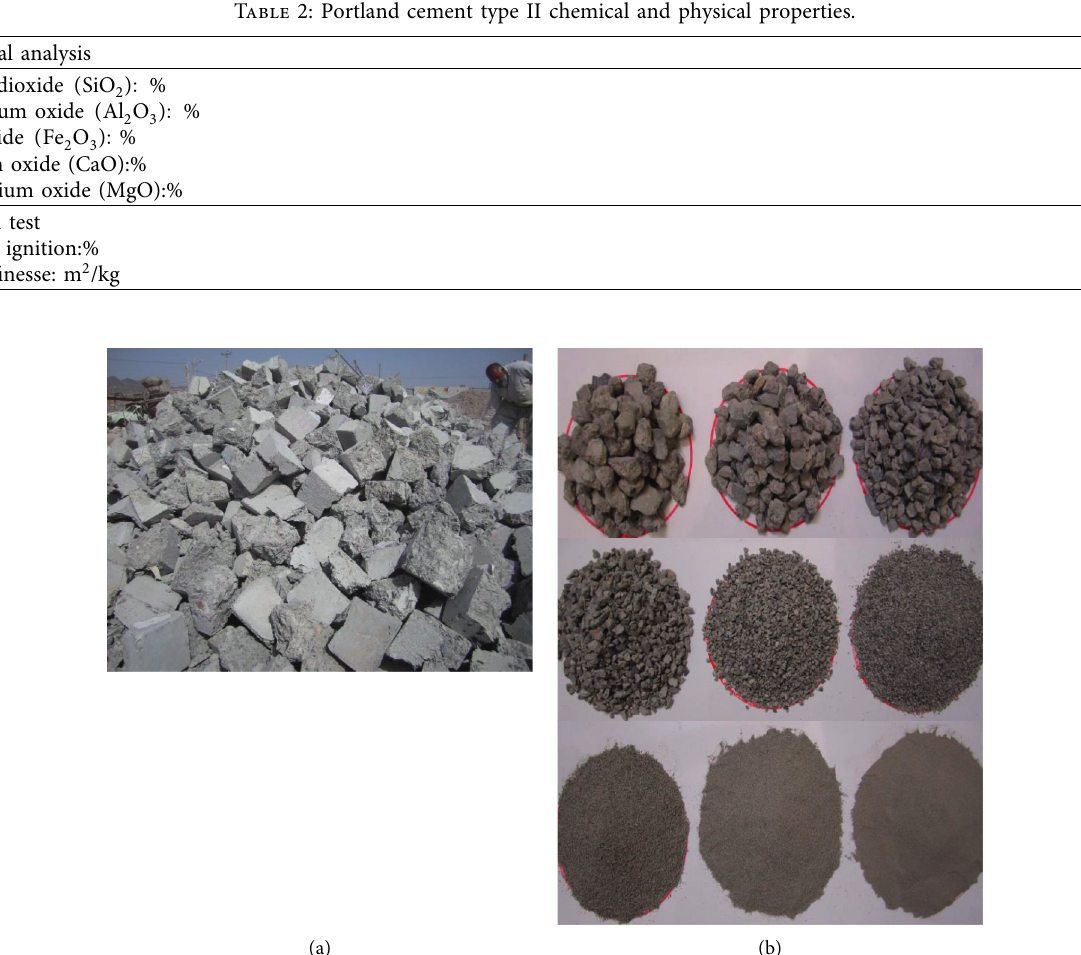
Figure 2: Recycled coarse and fine aggregates. (a) Demolished concrete. (b) Sieved coarse and fine aggregates (19mm, 12.5mm, 9.5mm,